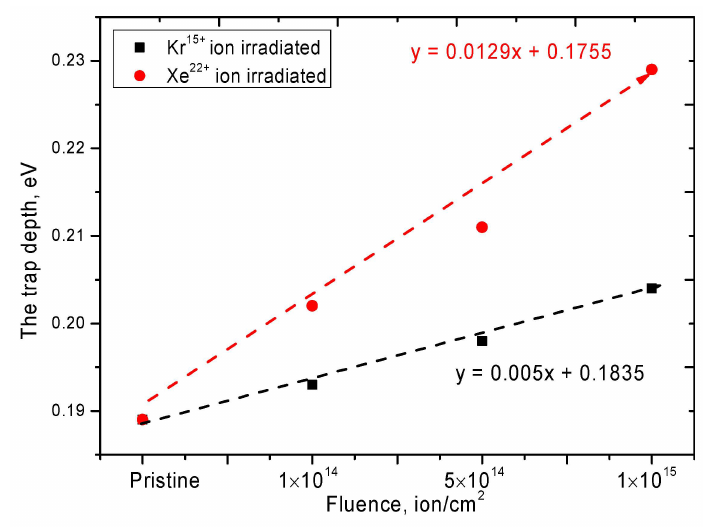
Figure 3. Graph of the electron trap depth change versus radiation dose.